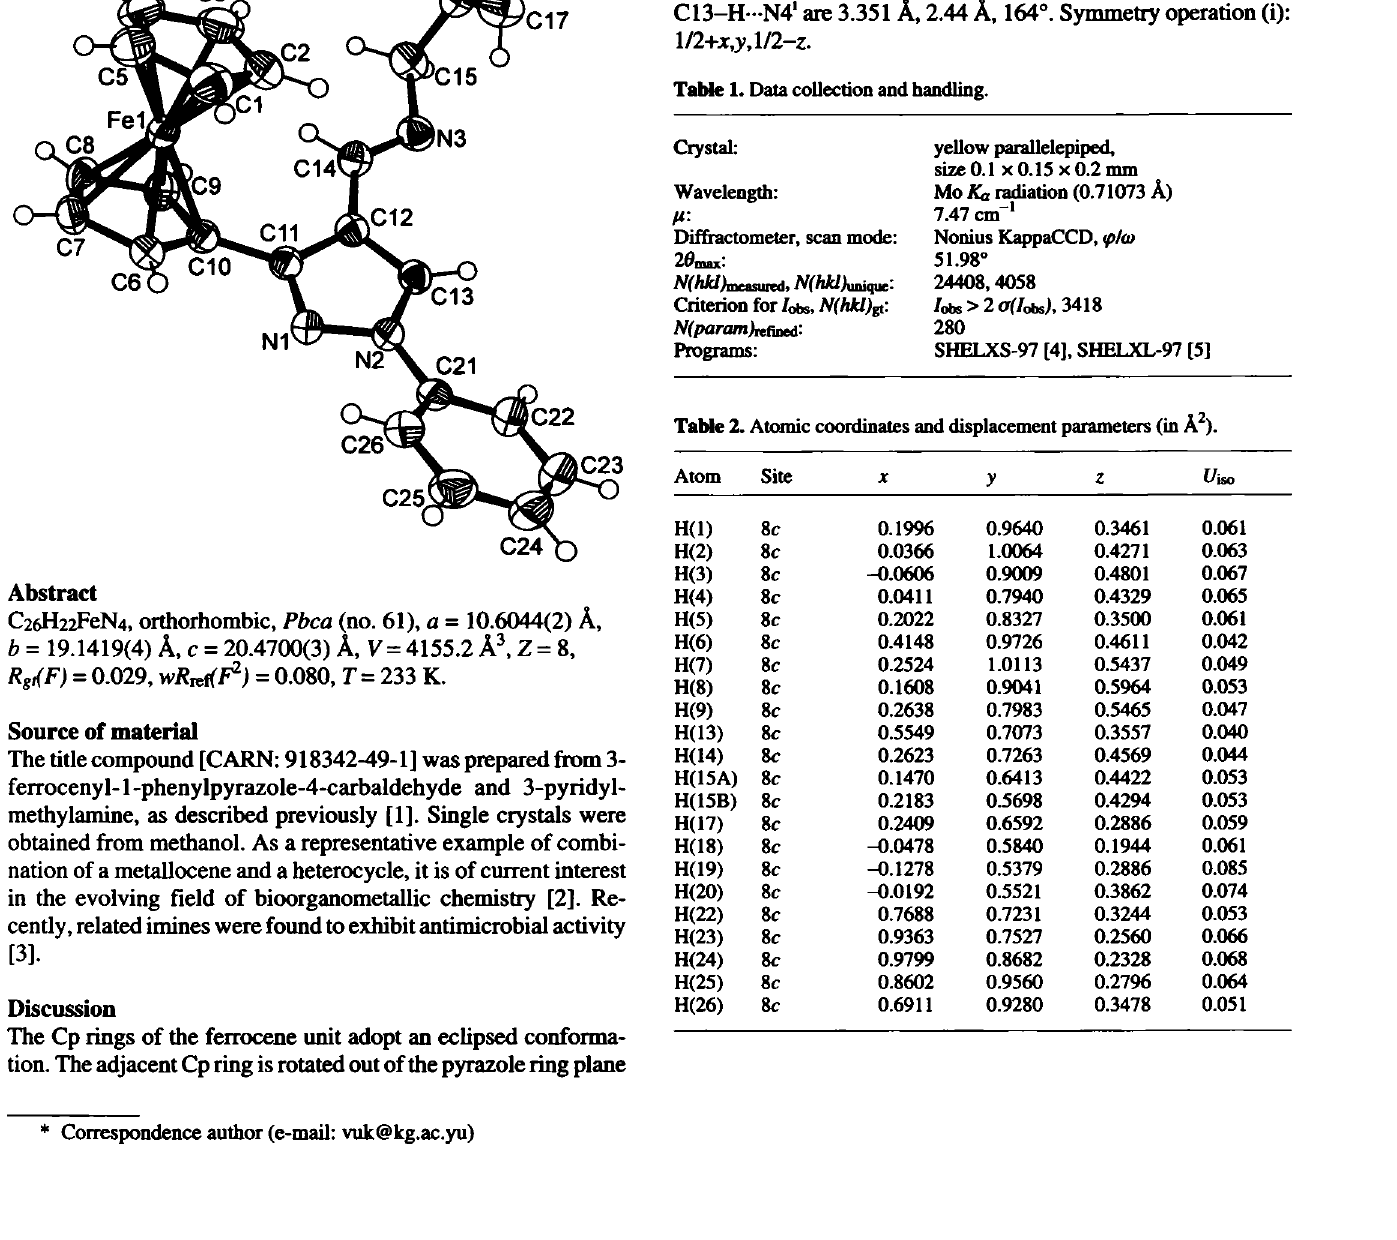
Table 2. Atomic coordinates and displacement parameters (in Ä 2